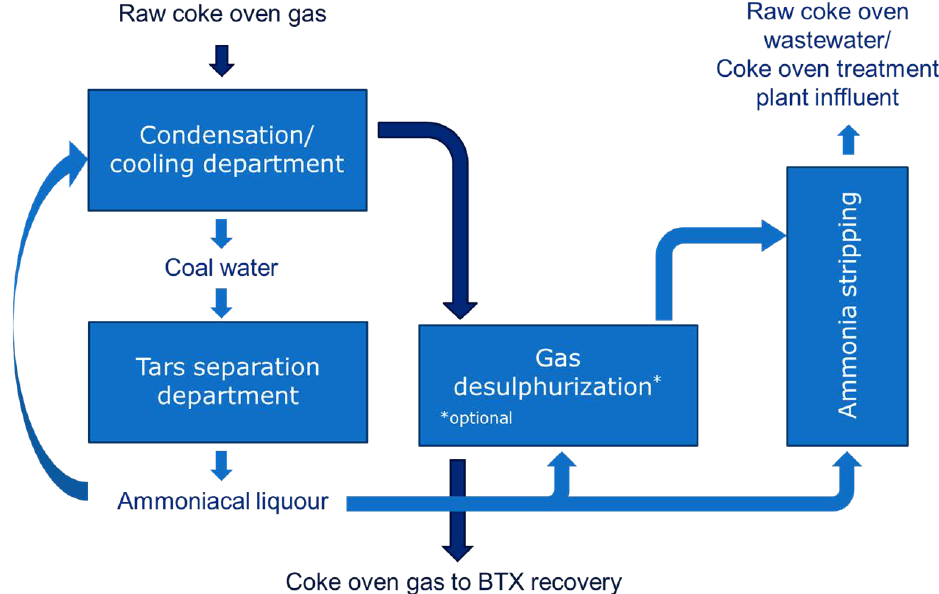
Figure 2: The scheme of formation of coke oven